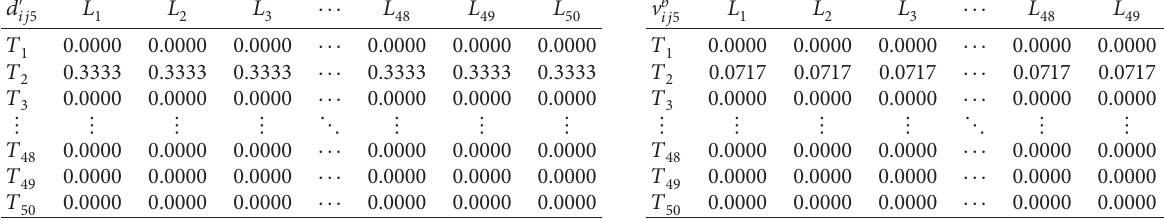
� [ v b ] for tenants’ ij 5 50 × 50 5